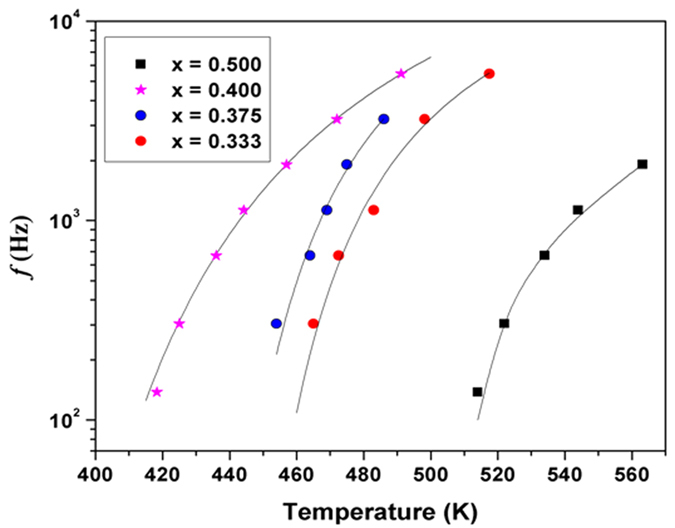
Variation of peak maxima of relaxation peak (Tm) with frequency for orthorhombic solid solution phases in SrTi1−2xFexTaxO3 system.Solid lines are fits to the Vogel-Fulcher relation.